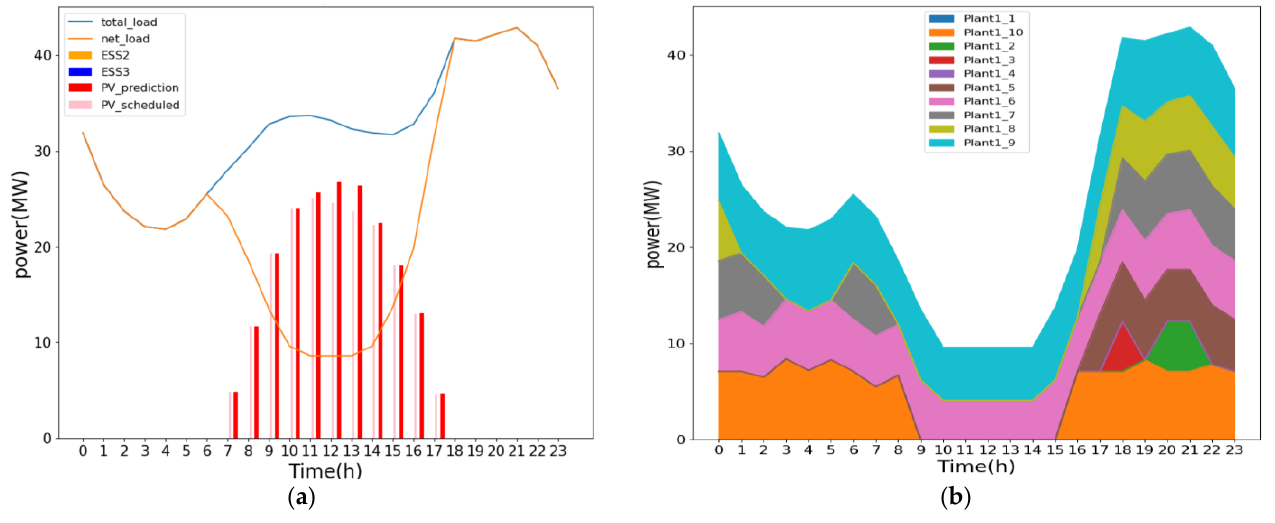
Figure 14. Case 2: Result of the scenario without ESS for ( a ) the PV generation and ( b ) the power output of the diesel generators.